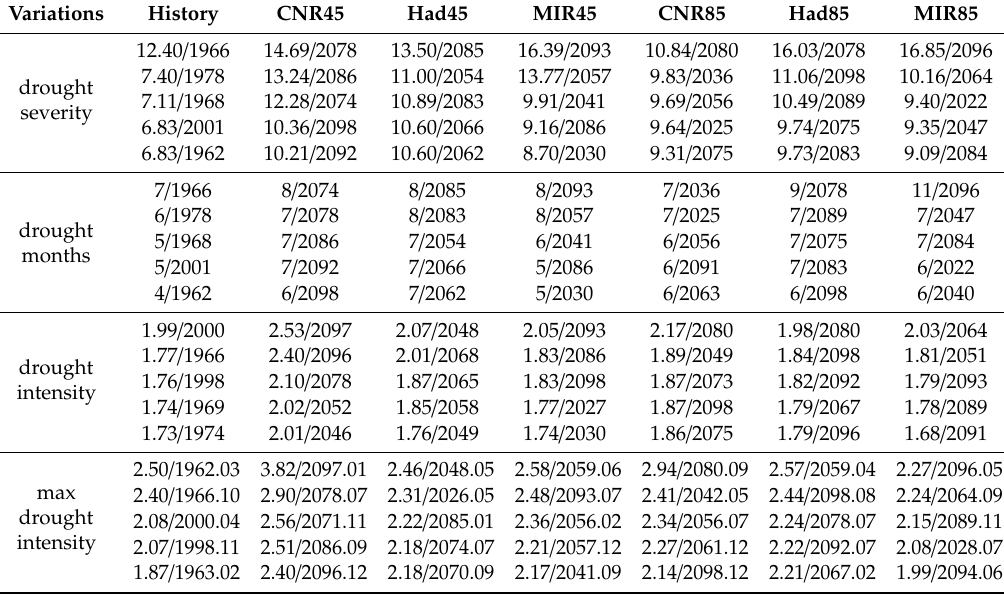
Table 9. Values of top five annual drought characteristics historically and in the